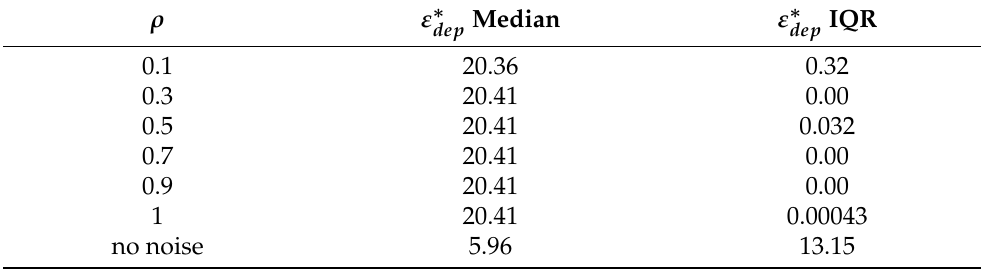
Table 1. Median and IQR of data-dependent privacy loss for student privacy parameter ρ .